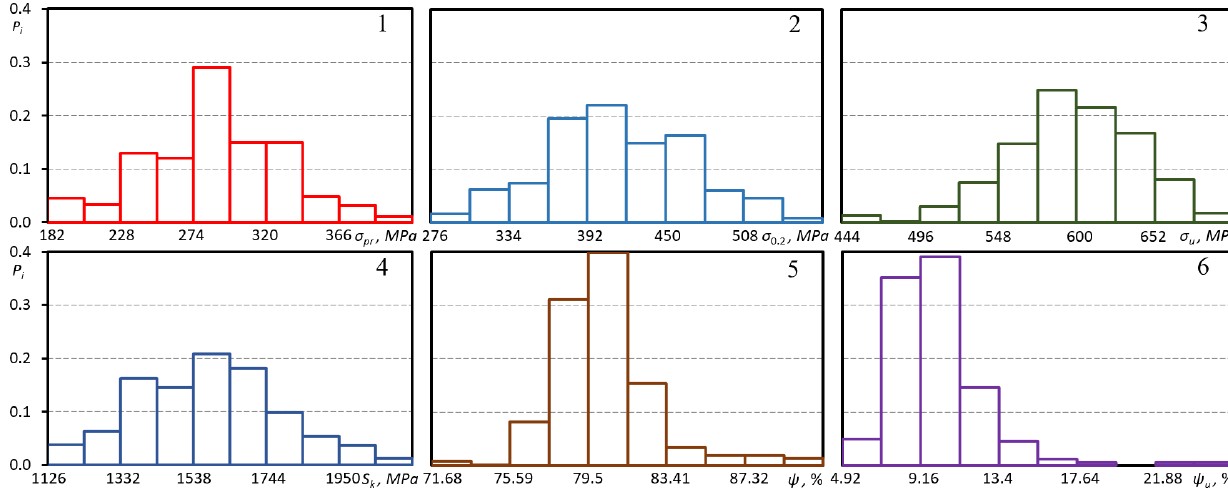
Figure 2. Histograms of mechanical properties of steel 15Cr2MoVa (1 — σ pr ; 2 — σ 0.2 ; 3 — σ u ; 4 — S k ; 5 — ψ ; and 6 — ψ u ).